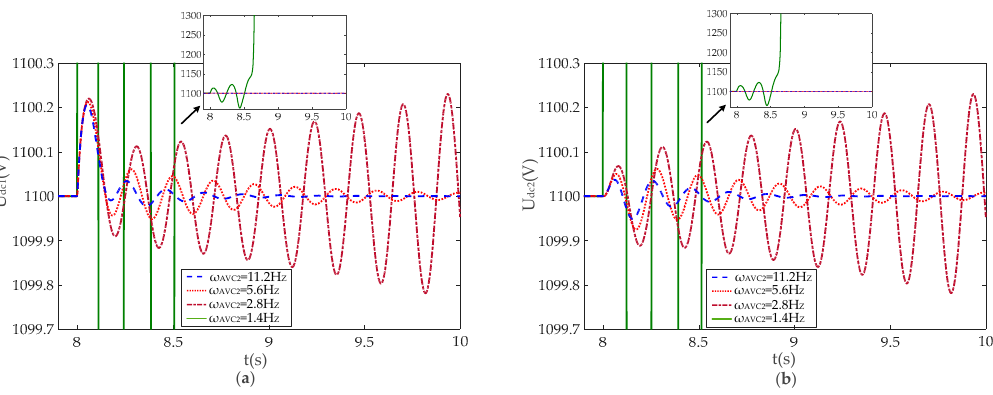
Figure 14. DC ‐ link voltage responses under different VSC2’s AVC bandwidths in ( a ) VSC1, ( b ) Figure 14. DC-link voltage responses under di ff erent VSC2’s AVC bandwidths in ( a ) VSC1, ( b ) VSC2.